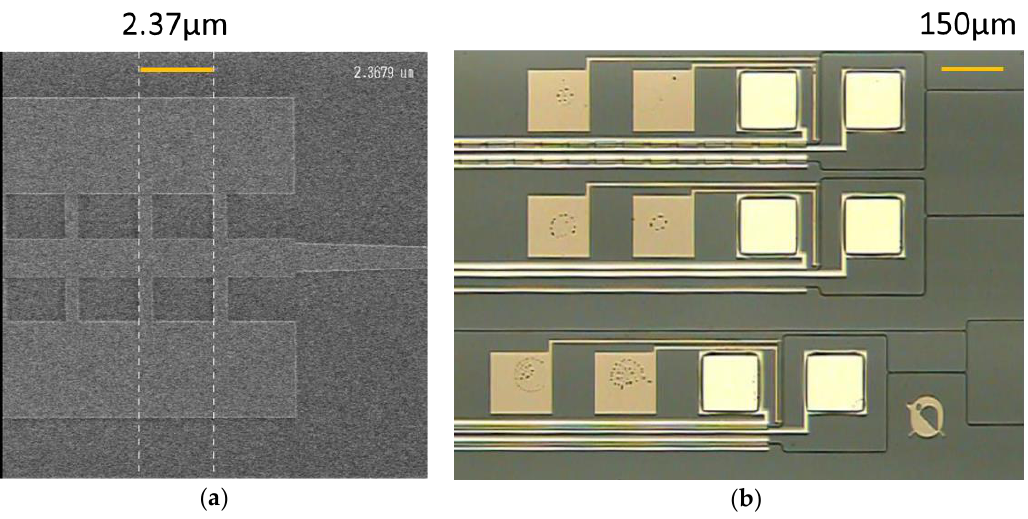
Figure 3. Layout of a phase modulator based on MMI.